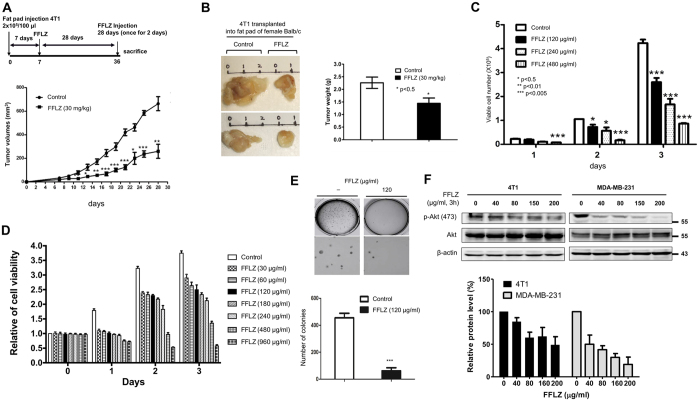
Fucose-containing fraction of Ling-Zhi (FFLZ) inhibits carcinogenesis in vivo and in vitro.(A) FFLZ inhibits tumor growth in 4T1-bearing mice. 4T1 cells were implanted into mice mammary fat pad tissue (n = 6 in each group). After 7 days, mice were treated with FFLZ (30 mg/kg) i.p. injection at intervals of 2 days for 28 days. Data shown are the mean ± standard deviation from three independent experiments. (B) Image and tumor weight of 4T1 transplanted into fat pads of female BALB/c mice. (*p < 0.05, **p < 0.01, ***p < 0.001; log-rank test for significance). (C) 4T1 cells (1 × 105/well in 12-well plate) were treated with various dosages of FFLZ (120–480 μg/ml) for 1–3 days as indicated. The viability of cells was determined by cell counting assay. (D) 4T1 cells (1 × 104/well in 96-well plate) were treated with various dosages of FFLZ (30–960 μg/ml) for 1–3 days as indicated. Cell viability of cells was determined by the MTT assay. Each group at 30–960 μg/ml of FFLZ is normalized to each un-treated control. The data are representative of three separate experiments with mean ± SD; error bars indicate SD. (E) Approximately 3,000 cells were seeded into each well of a six-well plate. The wells were filled with melted 0.33% agar solution, followed by treatment with FFLZ (120 μg/ml) for 26 days. The cell numbers of the colonies formed were determined, and the values shown represent the means ± SD, *p < 0.05, and quantitation of colony formation ability. (F) FFLZ decreases phosphorylation of Akt (a TGFR-non-Smad signaling pathway). 4T1 and MDA-MB-231 cells (1 × 105 cells/ml) were treated with FFLZ (0–200 μg/ml) for 3 h. Total cell lysates were collected after the indicated incubation times and analyzed by western blot assays for phosphorylated AKT. Relative quantification analysis of phosphorylation-AKT band intensities by ImageJ. Representing one of three separate determinations in same experimental conditions.